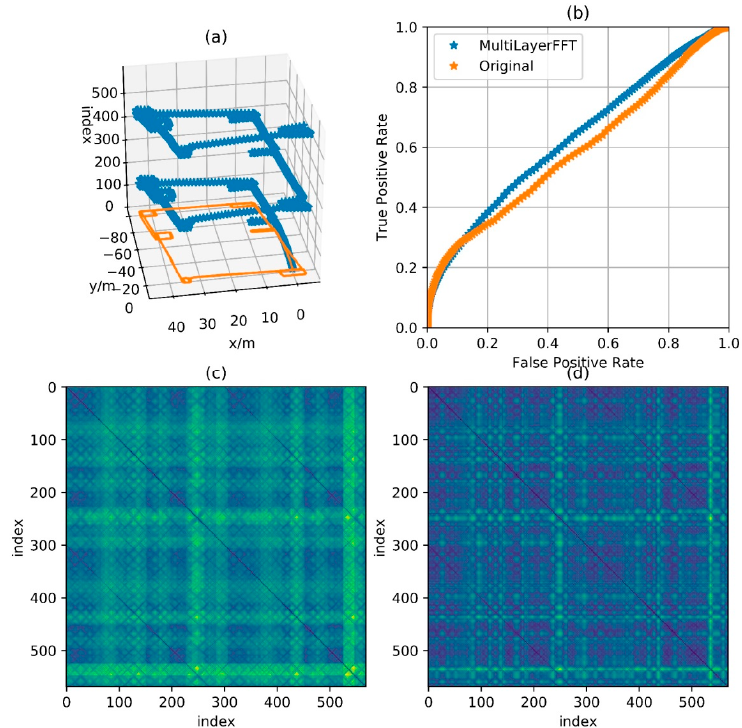
Figure 11. Comparison of performance between BDD and MFD in Path A. ( a ) Reference trajectory. ( b ) ROC of BDD and MFD. ( c ) Distance matrix of BDD. ( d ) Distance matrix of MFD.